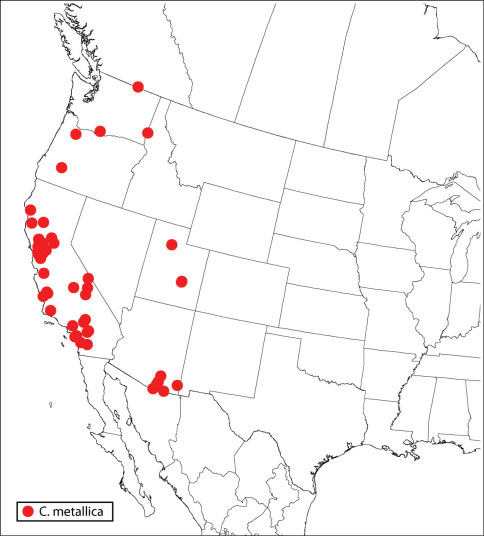
Regional distribution of Calosota metallica.